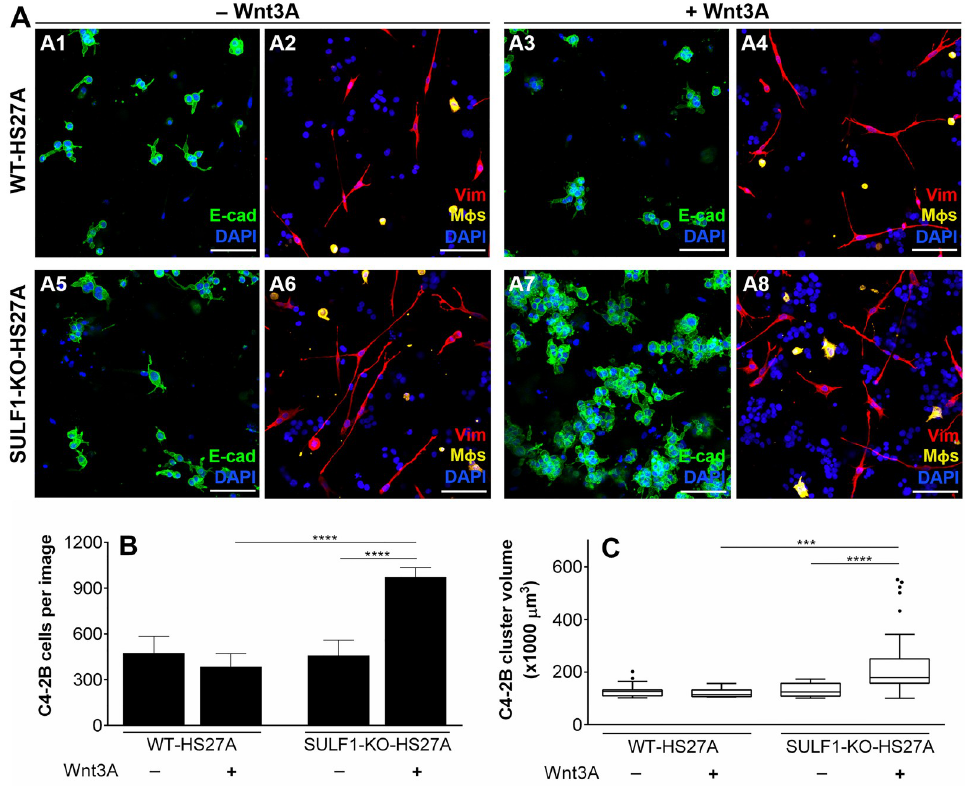
Fig 5. Effect of Wnt3A treatment on tricultures of C4-2Bs, Wild-type (WT) or SULF1 knockout (SULF1-KO) HS27As, and M ϕ s, encapsulated in biomimetic hydrogels. Biomimetic collagen-HA hydrogels were prepared with the addition of human recombinant PlnDm1, pre-loaded with 200 ng of Wnt3A (+Wnt3A) or BSA (-Wnt3A), as detailed in Materials and Methods. In each hydrogel, 40.000 C4-2B, 10.000 HS27A and 5.000 M ϕ s were initially encapsulated. On day 5 after encapsulation, the hydrogels were fixed and prepared for immunostaining, as explained in Materials and Methods. Immunofluorescence stainings show E-cad (green) (A1, A3, A5 and A7), and vimentin (Vim; red) (A2, A4, A6, A8), with DAPI (blue) counterstain. E-cad and Vimentin signals were used to quantify total C4-2B cellularity (B) and cluster volume (C) via IMARIS software, as described in Materials and Methods. In A2, A4, A6 and A8, macrophages (vimentin-positive) were pseudo-colored in yellow according to cellular sphericity, as specified in Materials and Methods. Staining of CD206 also was performed in the hydrogel groups in this experiment (S10 Fig). Scale-bar = 100 microns. Data shown represent the mean ± SD of three independent experiments. In each experiment, N = 5 hydrogels for each of the four groups. ��� , P < 0.001 and ���� , P < 0.0001.